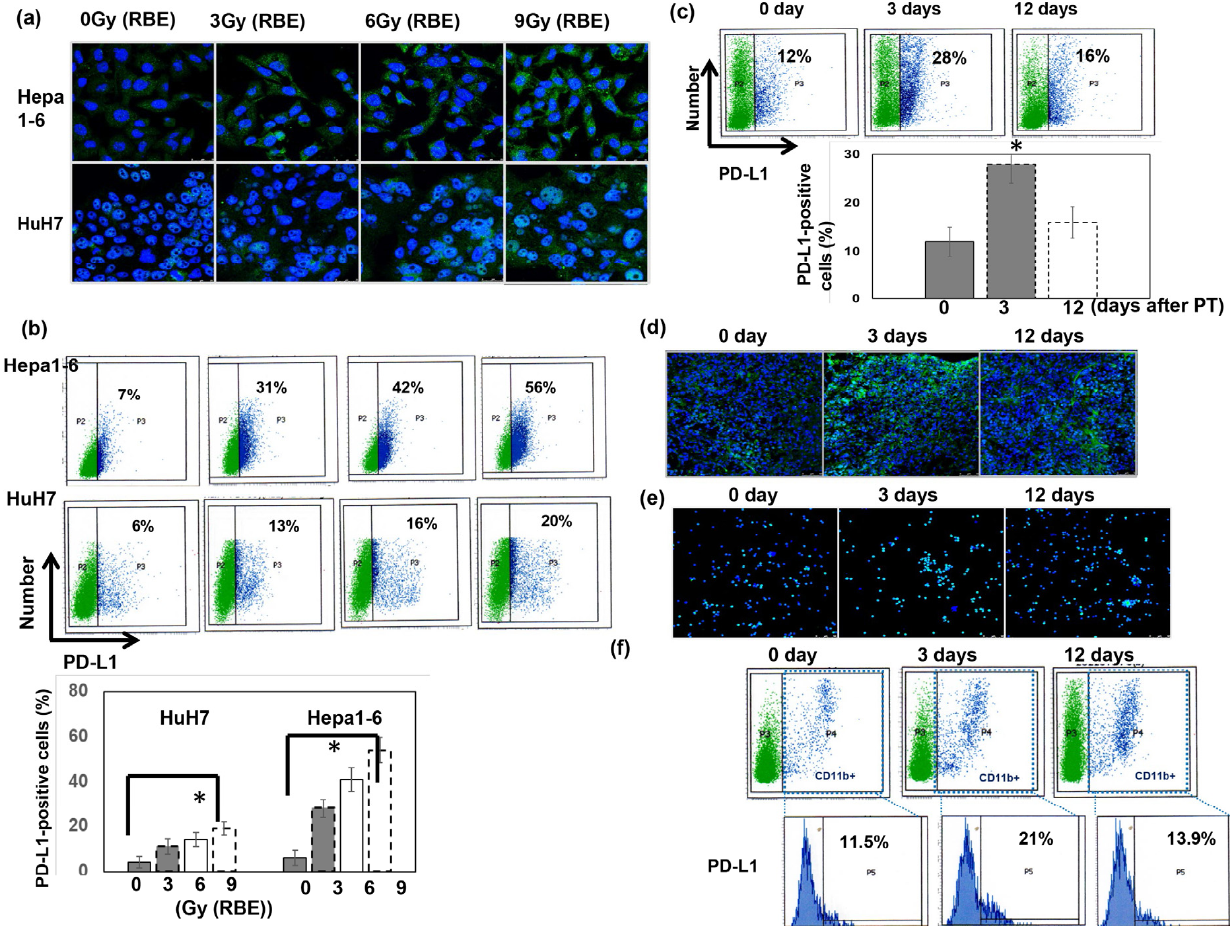
Figure 5. Effect of PT on PD-L1 expression. The levels of PD-L1 were evaluated using ( a ) IF (DAPI, blue; PD-L1, green), and ( b ) FACS staining for human and murine liver cancer cells at 48 h after PT in vitro and ( c ) FACS and ( d ) IF for murine liver tumors at the indicated times after PT for 12 Gy (RBE) in vivo. The y axis is the relative fold change in PD-L1 expression at the indicated conditions after PT. Data are presented as means ± standard errors of the mean. * p < 0.05. Furthermore, the expression of PD-L1 in murine CD11b+ cells following PT irradiation was evaluated via ( e ) IF and ( f ) FACS analysis (CD11b+ cells, blue spots).